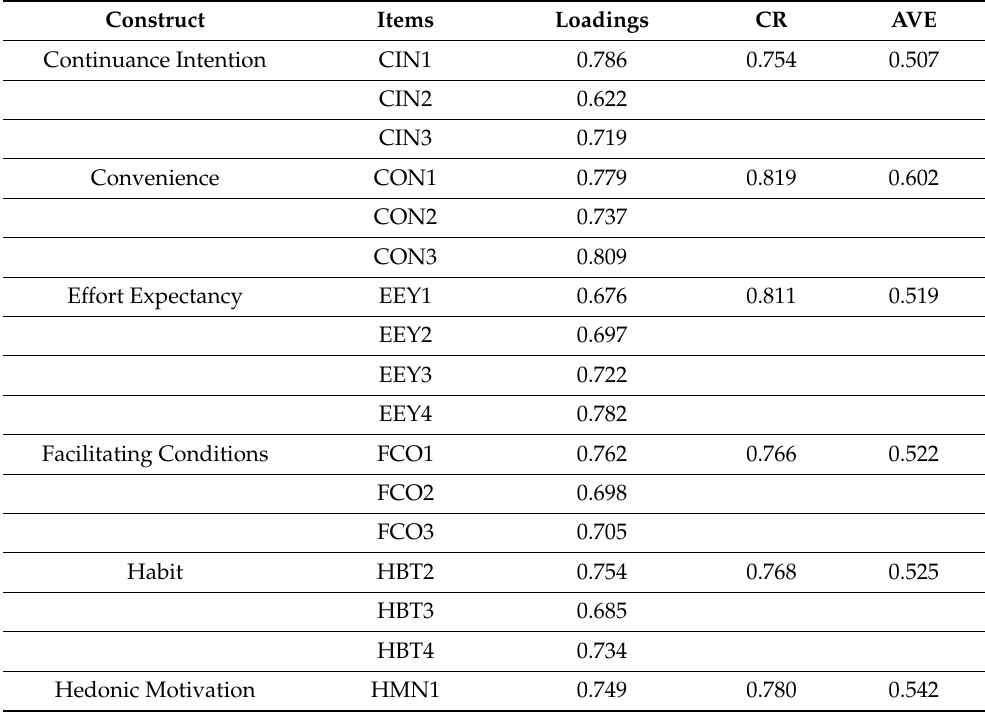
Table 2. Measurement